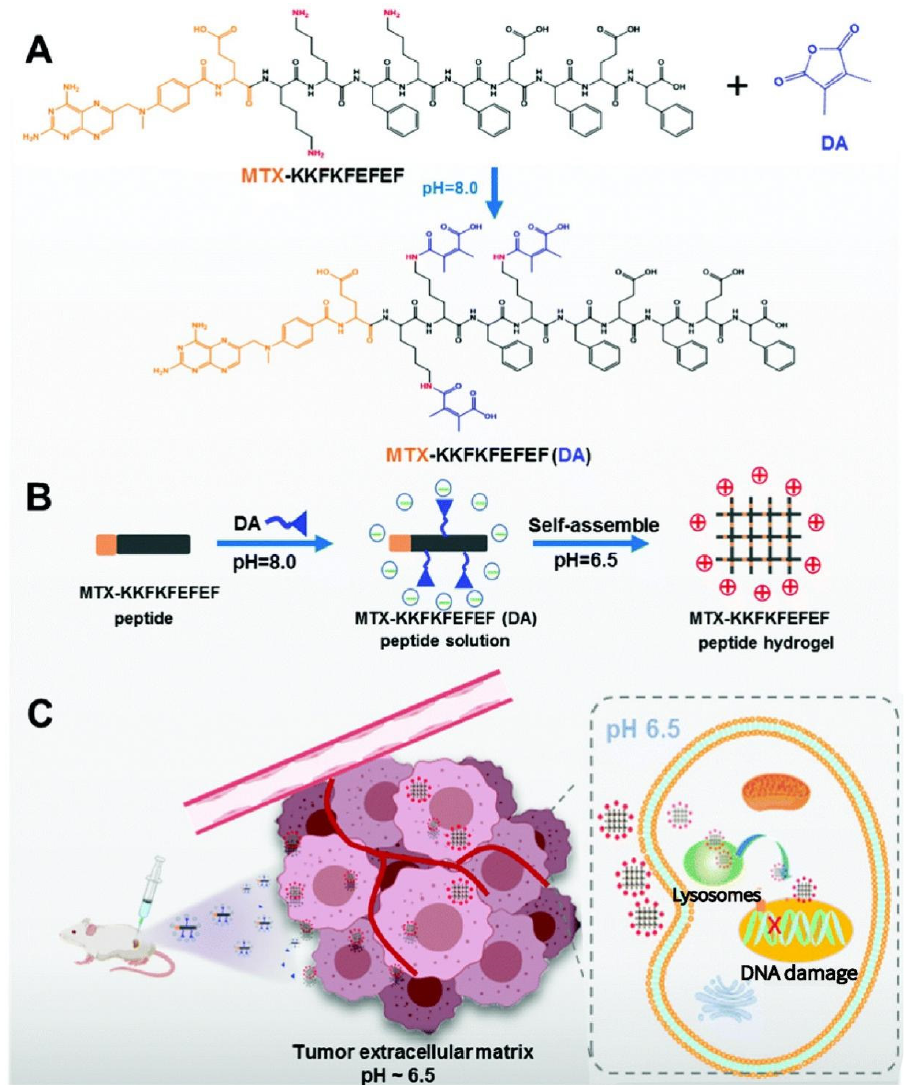
Figure 6. Schematic illustration of the formation of ( A , B ) the pH-responsive peptide hydrogel and ( C ) the anti-tumor mechanism of the pH-responsive peptide hydrogel at the tumor site. Reprinted with permission [152].